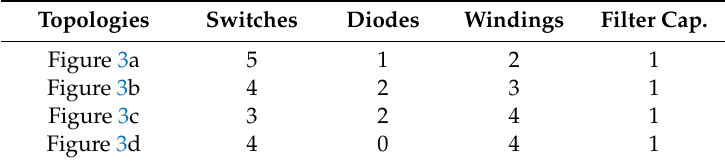
Table 2. Comparison of the component count of the tapped-inductor, buck-boost inverter family.